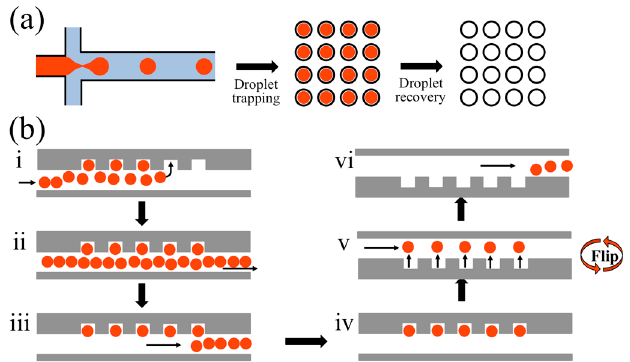
Figure 1. A schematic illustration for the workflow of the Floating Droplet Array (FDA). ( a ) General workflow involves droplet generation, trapping for analysis, and subsequent droplet recovery; ( b ) Step-by-step operation: (i) generated droplets flow into the trapping chamber and float into the wells. After all the wells have been filled (ii), the remaining droplets are purged (iii) and the trapped droplets are then analyzed (iv). Droplets are recovered by flipping the device so that droplets float out of the wells (v) and are sent for downstream handling on- or off-chip (vi).